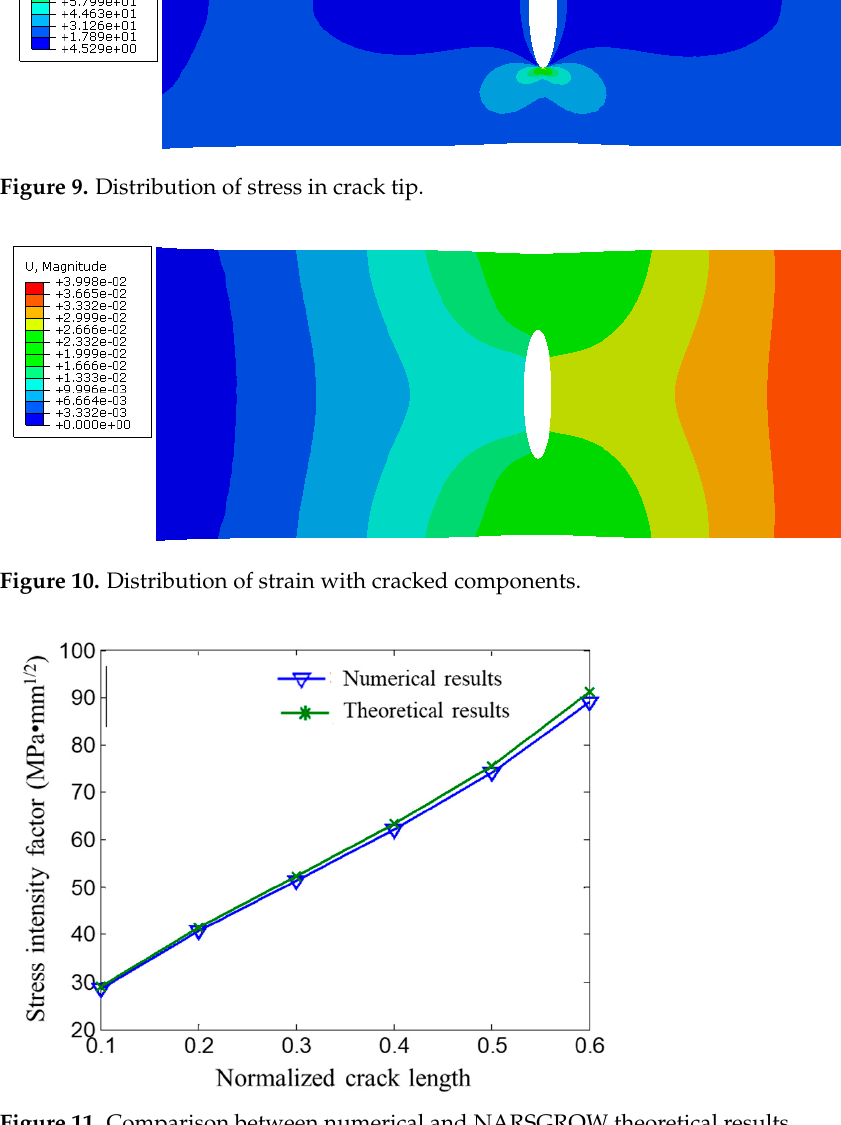
Figure 11. Comparison between numerical and NARSGROW theoretical results.